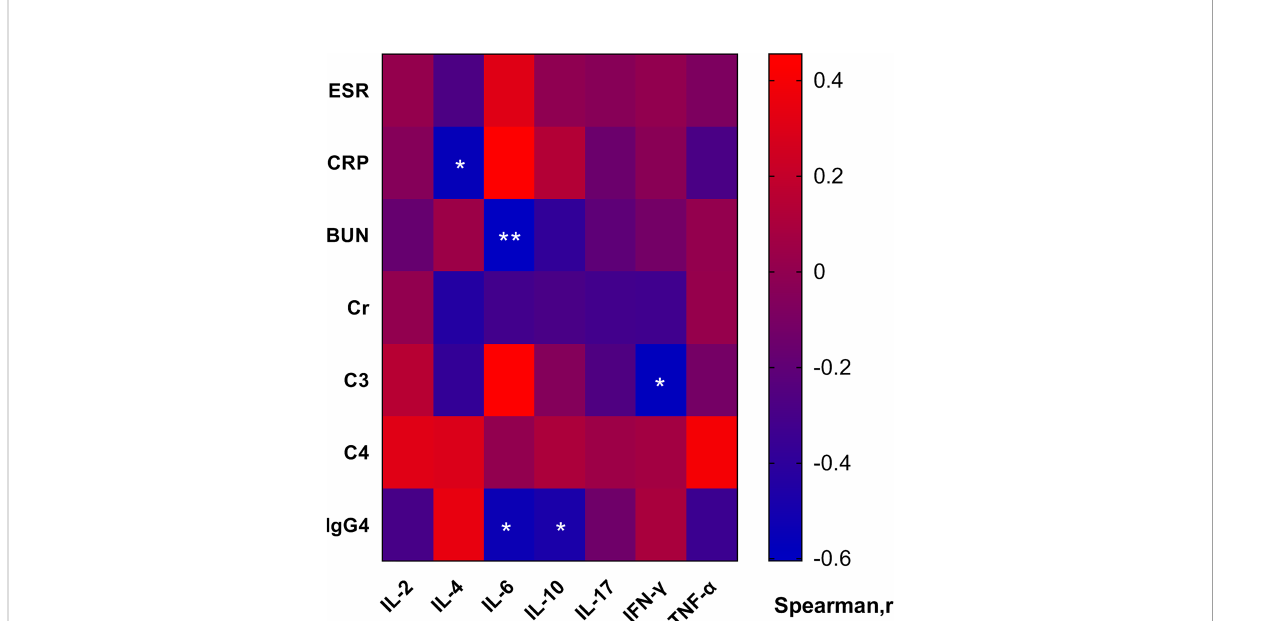
FIGURE 3 Heatmap of correlation of the serum cytokine levels with clinical and laboratory characteristics. In IRPF patients, IL-4 was negatively correlated with CRP, IL-6 was negatively correlated with BUN and IgG4, IFN- g was negatively correlated with C3. (*p < 0.05, **p <